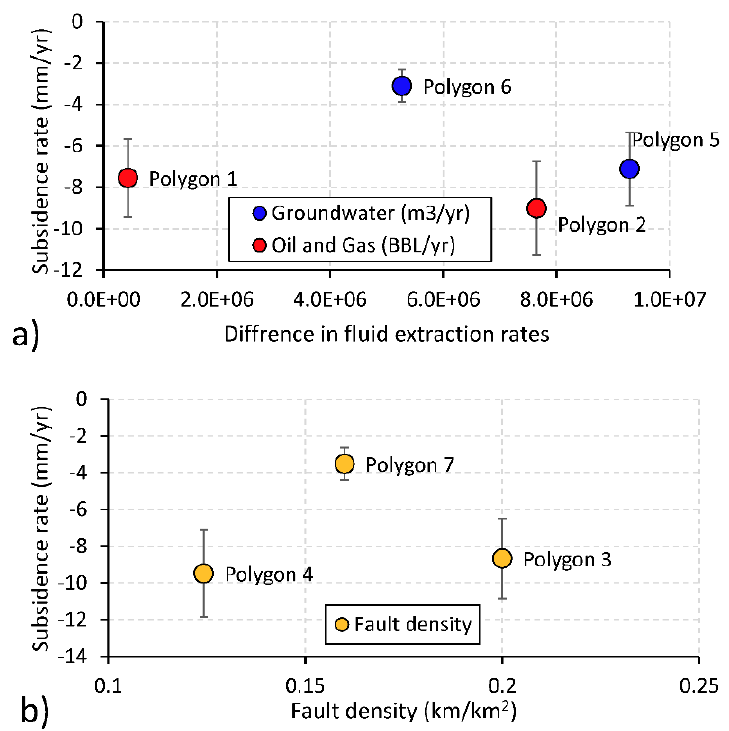
Figure 8. Relationship between land subsidence rates and fluid extraction ( a ), and fault density ( b ) for each of the investigated regions (polygons 1–7; Figure 6a). Fluid (groundwater and hydrocarbon) extraction is reported as the difference between the extraction rates during the study period (2016–2019) and the historical period (2000–2015). Land subsidence rates in polygons 1 and 2 were attributed mainly to oil/gas extraction, in polygons 5 and 6 to groundwater extraction, and in polygons 3, 4, and 7 to high fault density. Generally, land subsidence increased with fluid extraction and fault density.